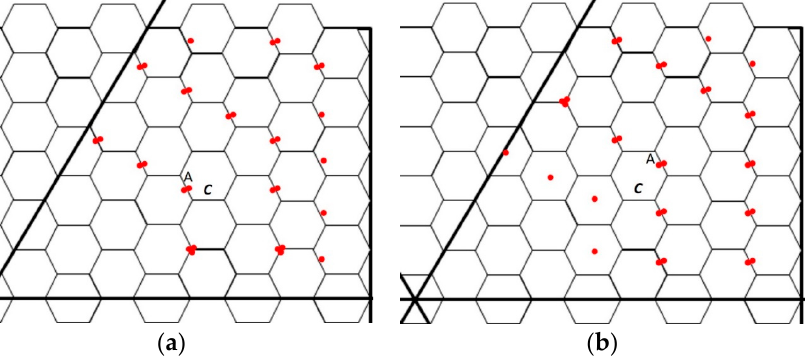
Figure 7. ( a ) Energy transmission in odd time slots. Sensors are represented by red dots. Sensor A in cell C moves to its upstream sensor and receives energy from it; ( b ) Energy transmission in even time slots. Sensors are represented by red dots. Sensor A in cell C moves to its downstream sensor and transmits energy to it.